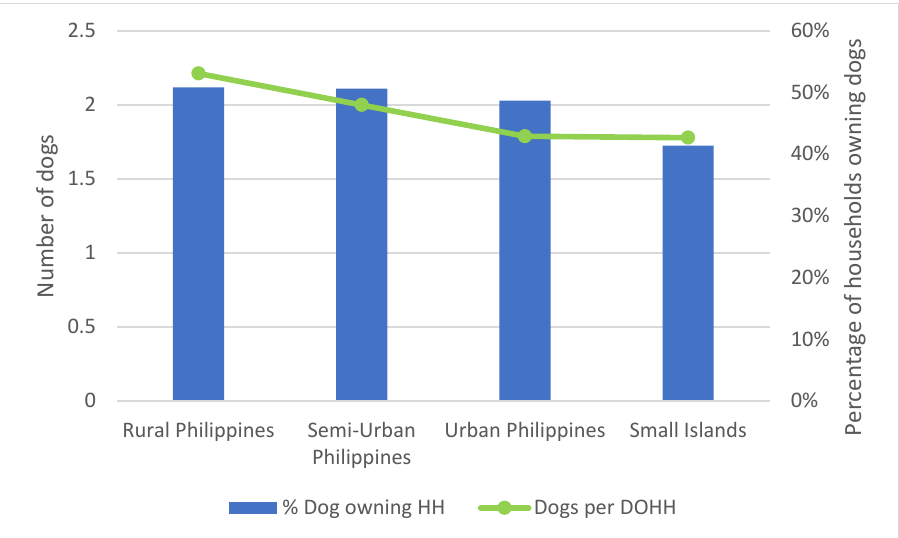
Figure 3. Dogs per dog owning household (DOHH) in different categories of human settlements (Rural, Semi-Urban, Urban and Islands). Table 1. Number of households surveyed, dog population estimates, dogs per 1000 humans, percentage of dog owning households, average number of dogs per household, dogs per dog